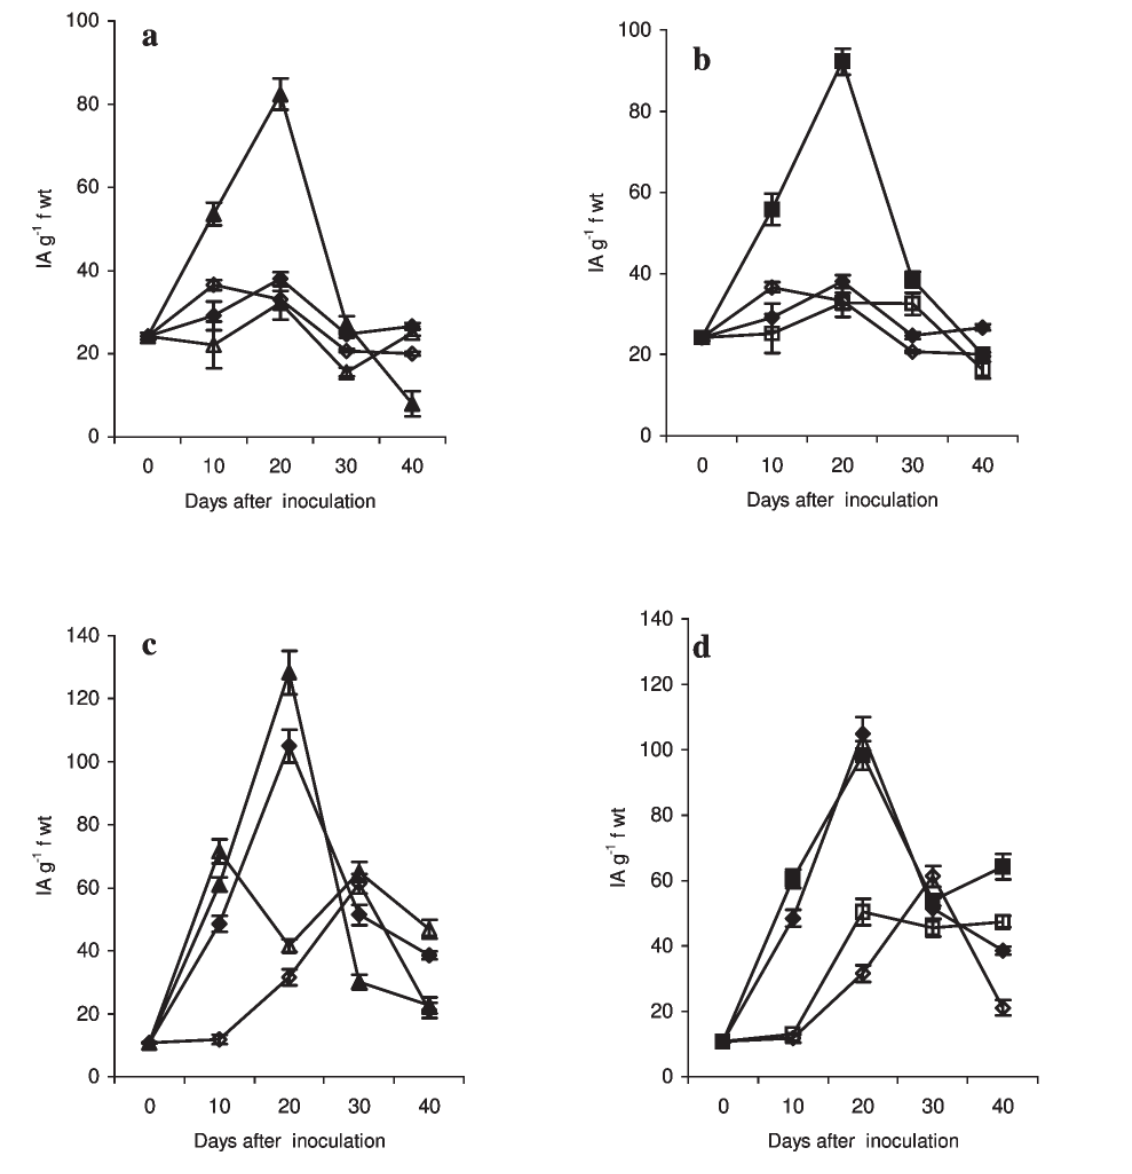
Fig. 4. Time-course diagram of biochanin A levels in the roots of the susceptible chickpea cv. ILC482 (a and b) and the moderately resistant cv. INRAT87/1 (c and d) subjected to various treatments - (cid:1) - water + water; - (cid:2) - Rhizobium isolate PchDMS + water; - (cid:1) - Rhizobium isolate Pch43 + water; - (cid:3) - Water + Foc; - (cid:4) - PchDMS + Foc; - (cid:5) - Pch43 +